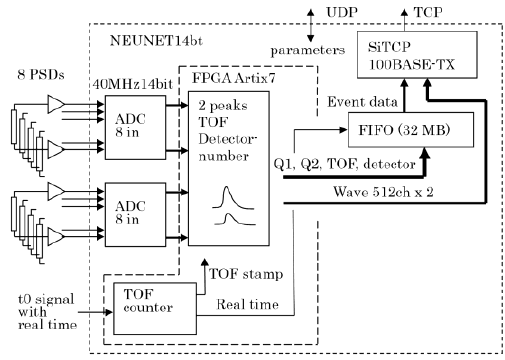
Fig. 4. Block diagram of the NEUNET system.